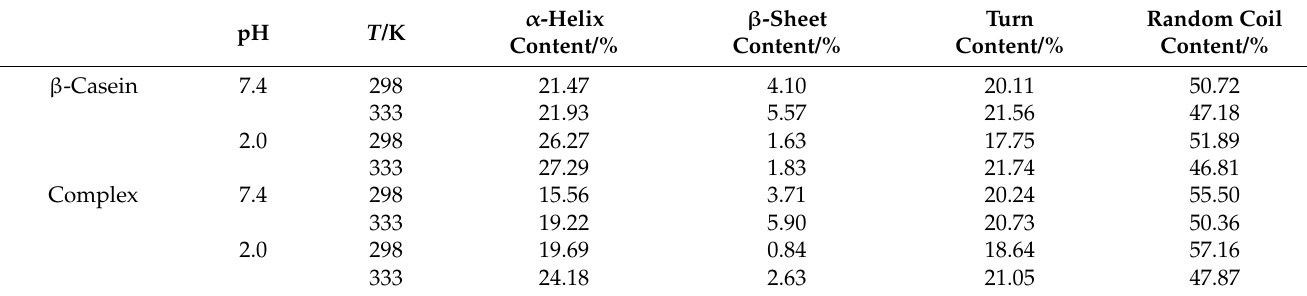
Table 4. Effect of temperature and pH on the composition of secondary structure of β -casein and β -casein-curcumin complex.